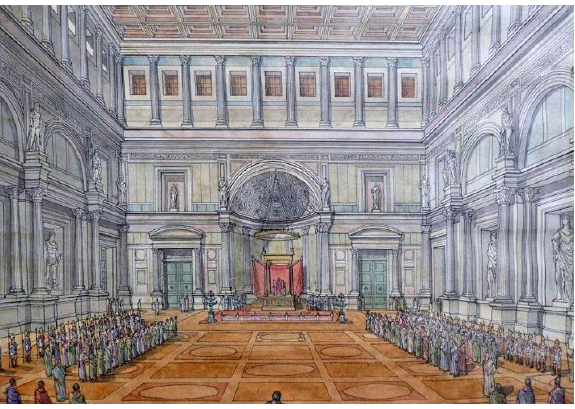
Figure 14. Aula Regia, Reconstruction Sketch of Flavian Palace, Source J C Golvin.